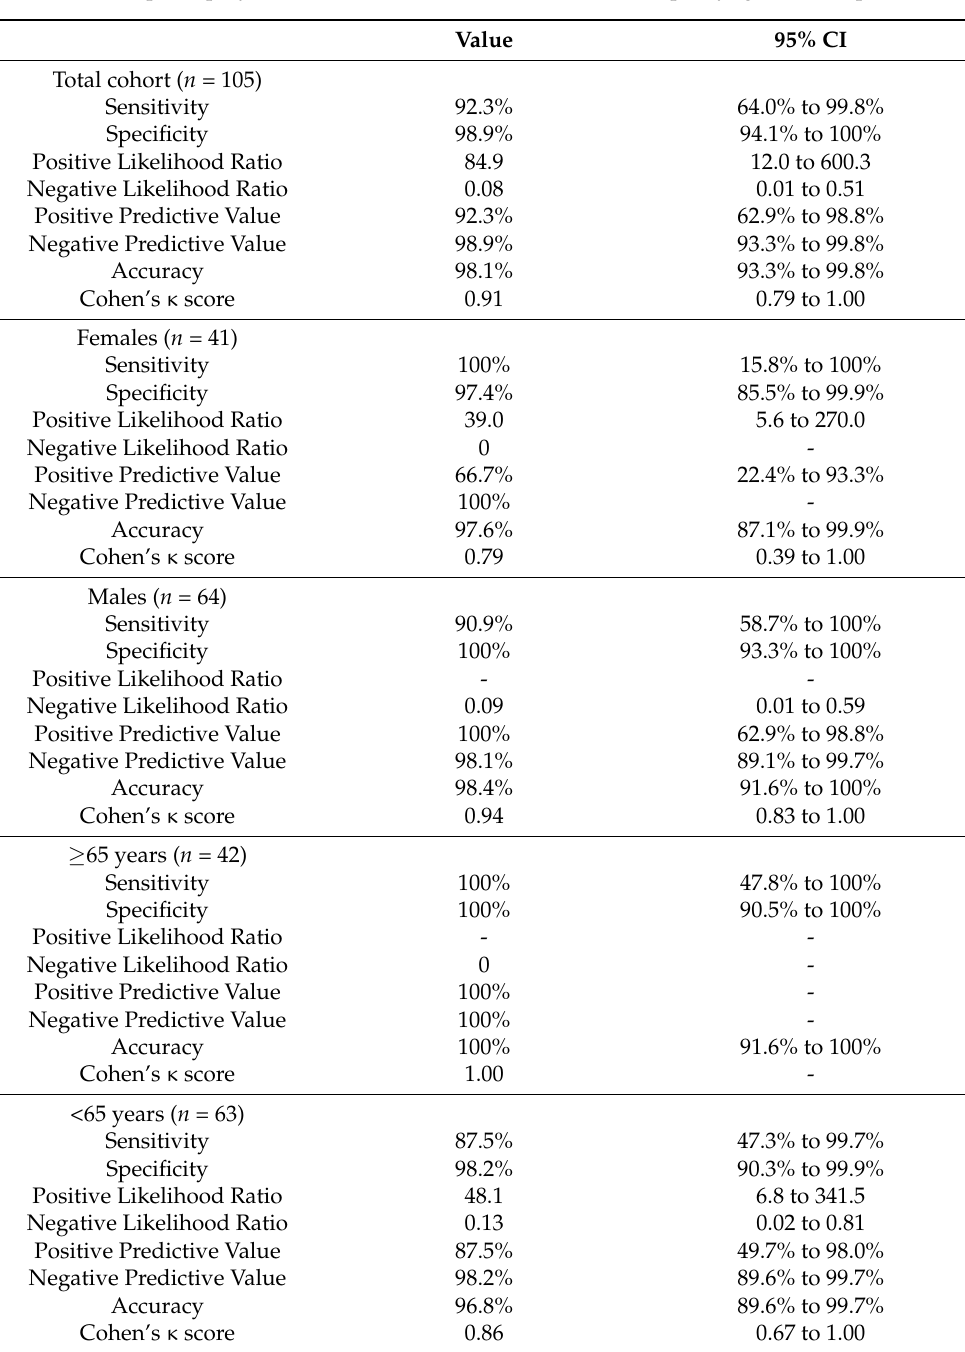
Table 4. Estimation of clinical performance of the Inflammacheck ® device compared to